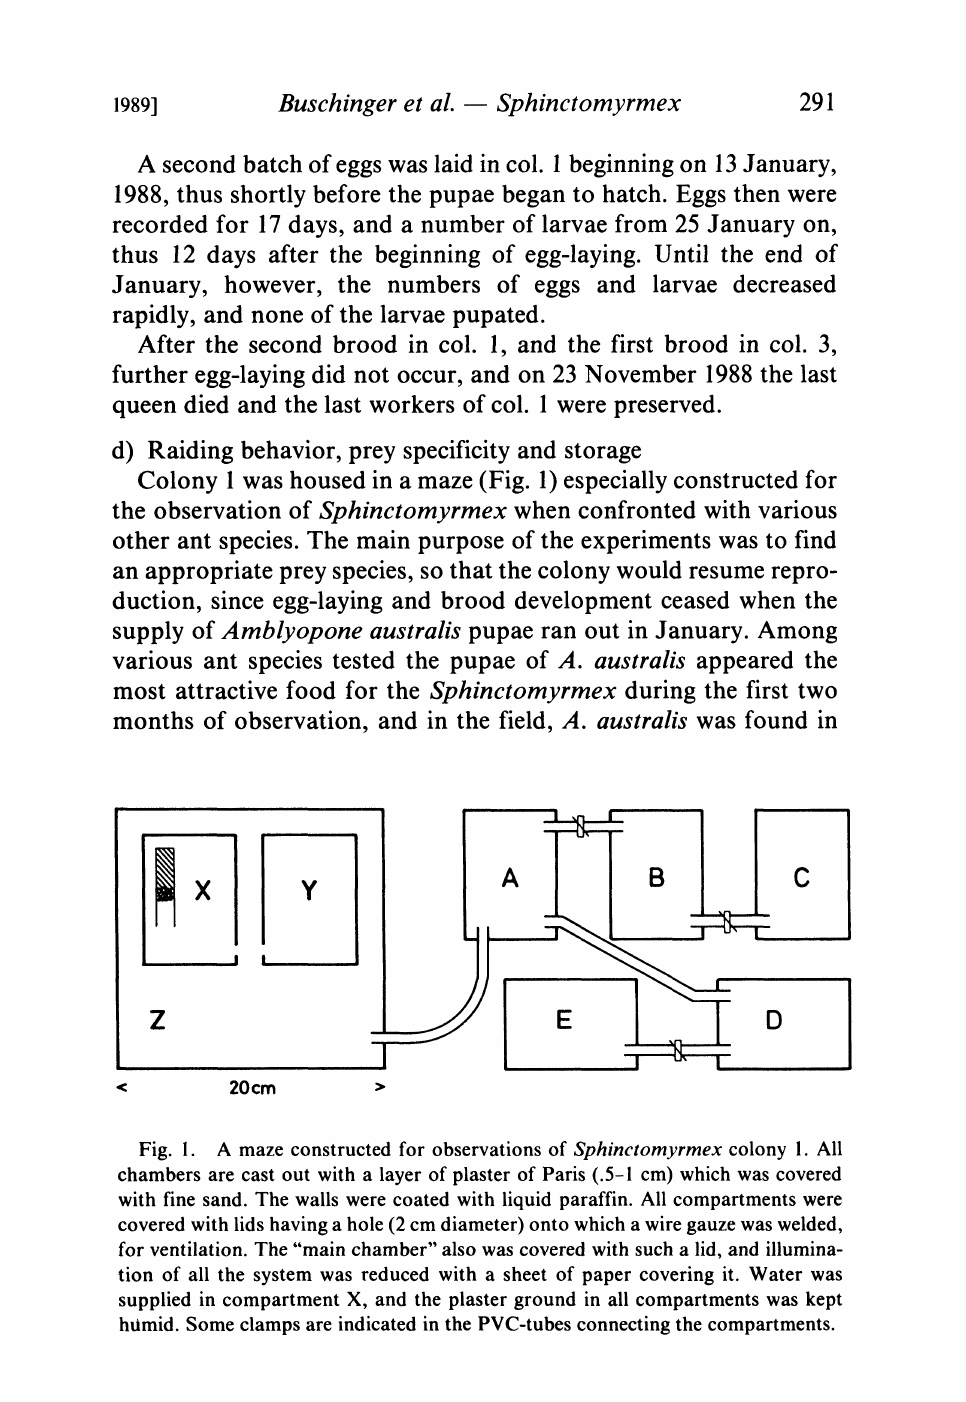
Fig. 1. A maze constructed for observations of Sphinctomyrmex colony 1. All chambers are cast out with a layer of plaster of Paris (.5-1 cm) which was covered with fine sand. The walls were coated with liquid paraffin. All compartments were covered with lids having a hole (2 cm diameter) onto which a wire gauze was welded, for ventilation. The "main chamber" also was covered with such a lid, and illumina- tion of all the system was reduced with a sheet of paper covering it. Water was supplied in compartment X, and the plaster ground in all compartments was kept humid. Some clamps are indicated in the PVC-tubes connecting the